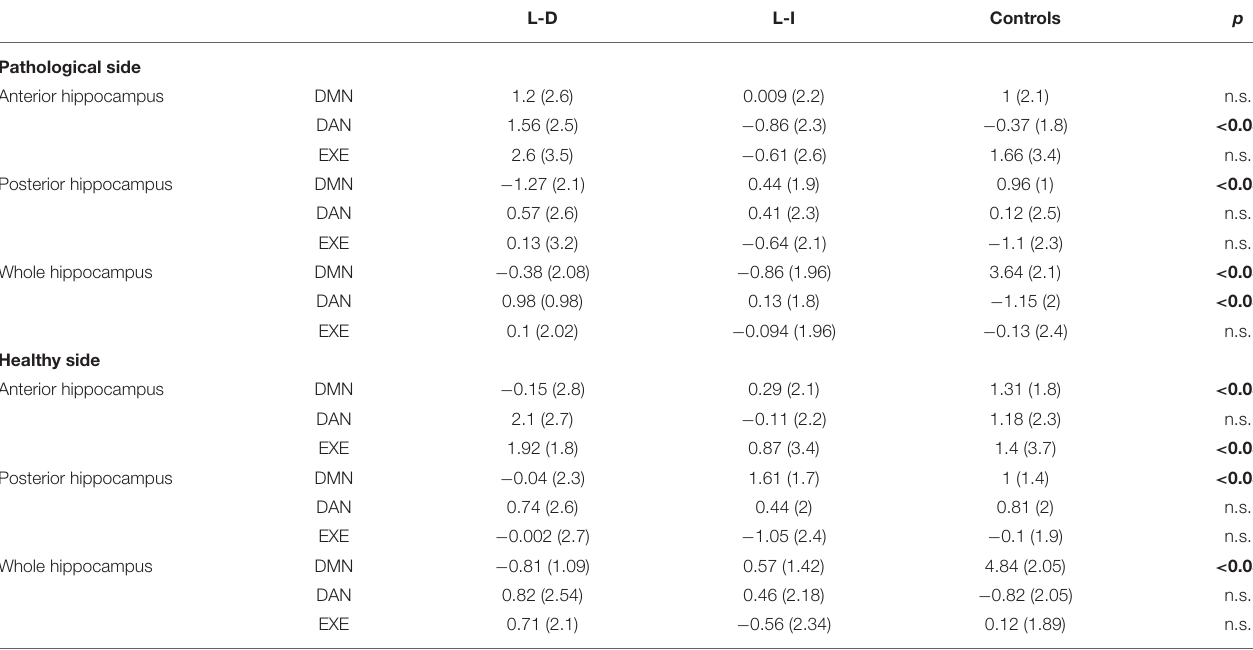
TABLE 3 | Connectivity analysis results for each group.